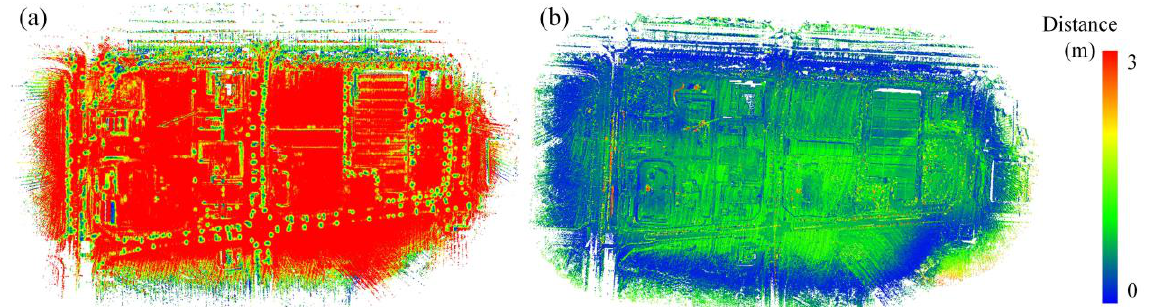
Fig.7. Distance between resulted laser points and AT points. (a) Laser points calculated using initial values. (b) Laser points calculated using values obtained by